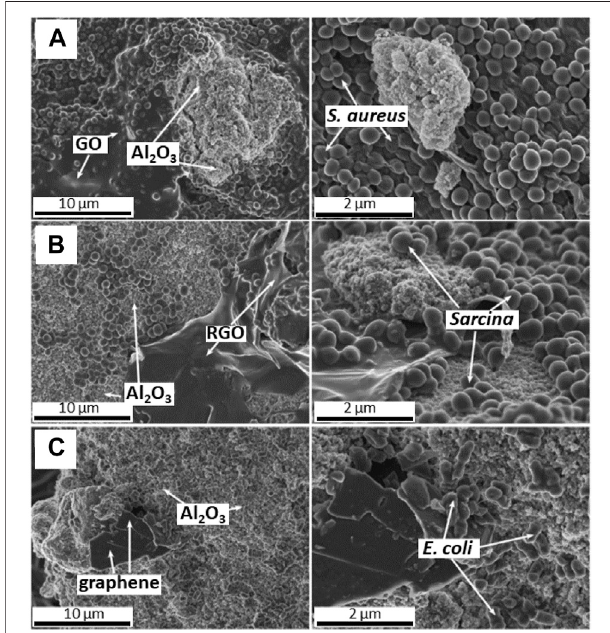
FIGURE 5 | SEM images of competitive biosorption between nano- Al 2 O 3 and GOtowards S.aureus cells (A) ,RGOtowards Sarcina cells (B) and graphene fl akes towards E. coli cells (C) (Reproduced with permission from (Jastrze ˛ bska et al., 2017b) with minor